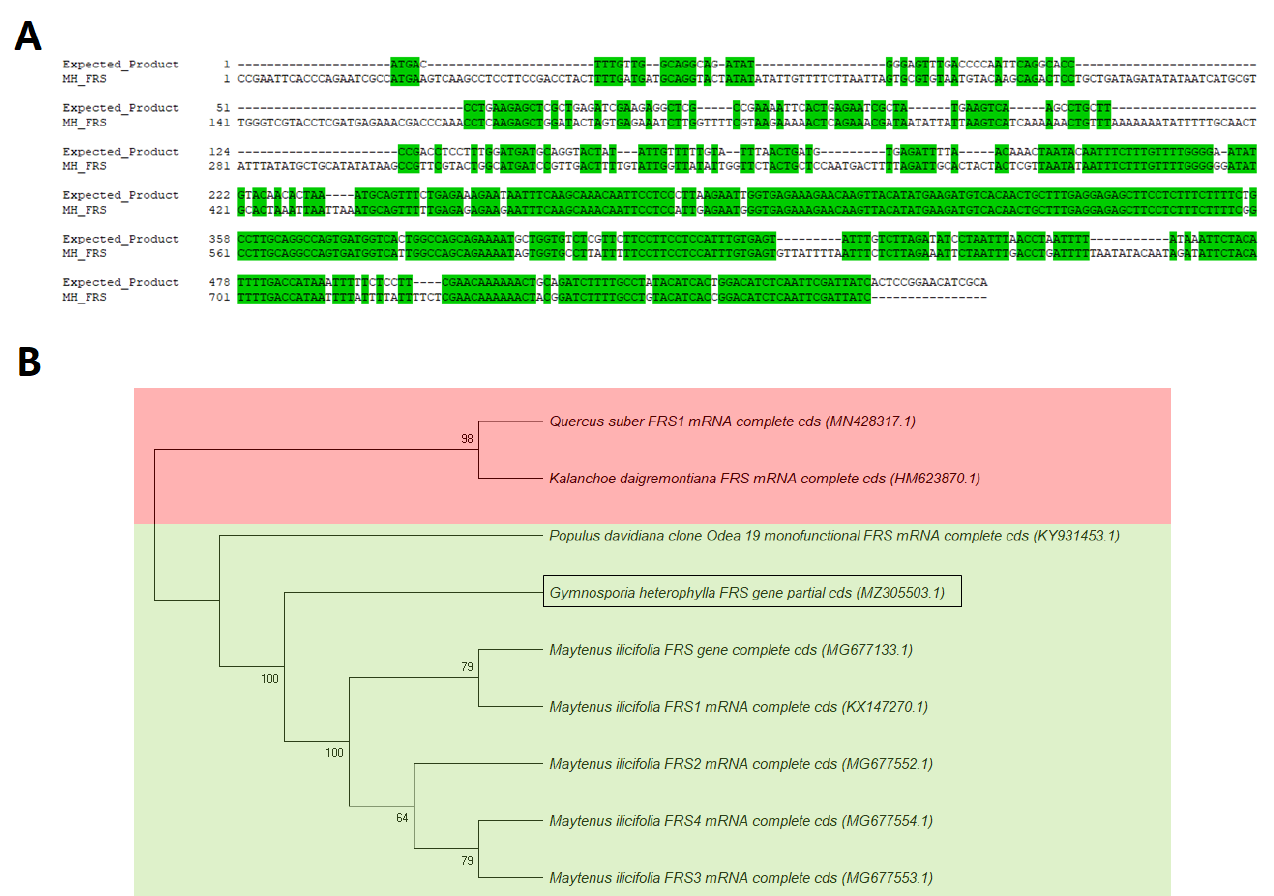
Figure 7. Pairwise alignment between the template PCR product of the FRS gene from M. ilicifolia and isolated PCR product of the FRS gene from G. heterophylla . Green highlights indicate the conserved bases ( A ); phylogenetic analysis of the obtained friedelin synthase (FRS) gene from G. heterophylla, and deposited FRS gene sequences in the NCBI database ( B ). This tree is deposited on the TreeBASE database (TreeBASE tree ID: tr131454). Multiple alignments are performed using the Muscle tool, and the phylogenic tree was constructed using the maximum parsimony (MP) method from MEGA-X software (Version 10.0.4). The bootstrap values are shown on the branch based on 1000 pseudoreplicates. The MP tree is obtained by applying the min-mini heuristic algorithm with a searching factor of 1. The green box indicates a shared cluster among the relevant plant species, while the red box indicates a non-related cluster of the FRS genes. A box indicates an obtained FRS gene from G. heterophylla (NCBI accession number: MZ305503.1).